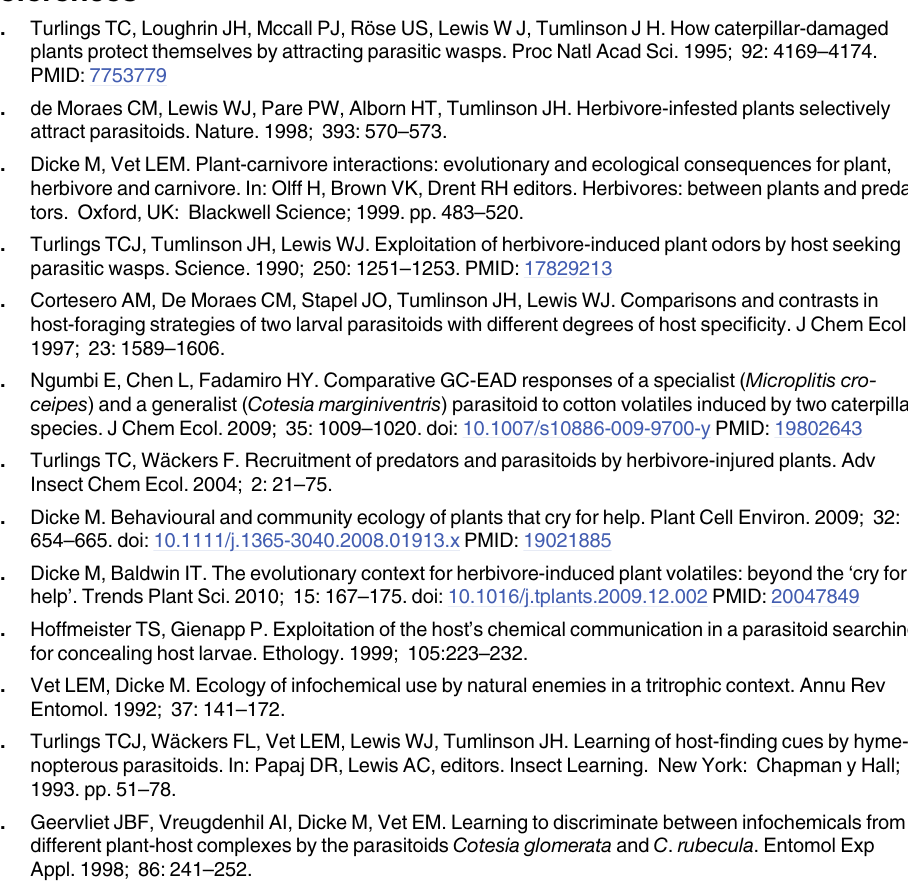
S3 Table. Latency times (mean ± S.E.) for the selection in the Y-tube olfactometer in experi- ment